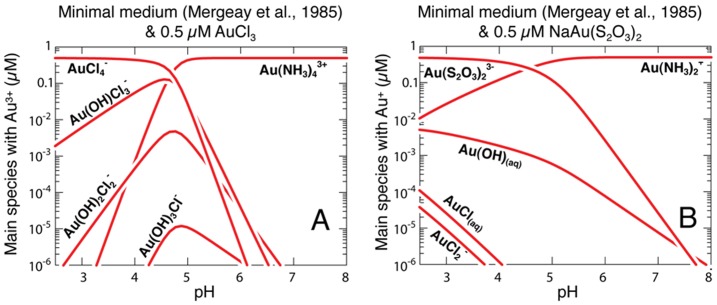
Chemical model showing the speciation of Au in growth media as a function of pH and oxidation state of Au.Chemical model, using Geochemist's Workbench (GWB; [31]), showing the speciation of 0.5 µM NaAu(III)Cl4(s) (a) and 0.5 µM Na3Au(I)(S2O3)2(s) (b), in minimal salt media (MSM, [28]) at pHs 2 to 8.